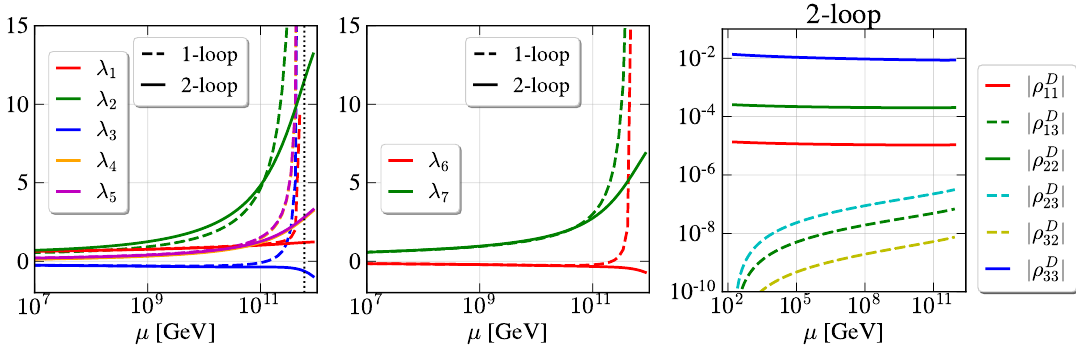
Figure 10 . Evolution of the parameter point in eq. (4.1); which is an example point from scenario III (hard broken Z 2 in the